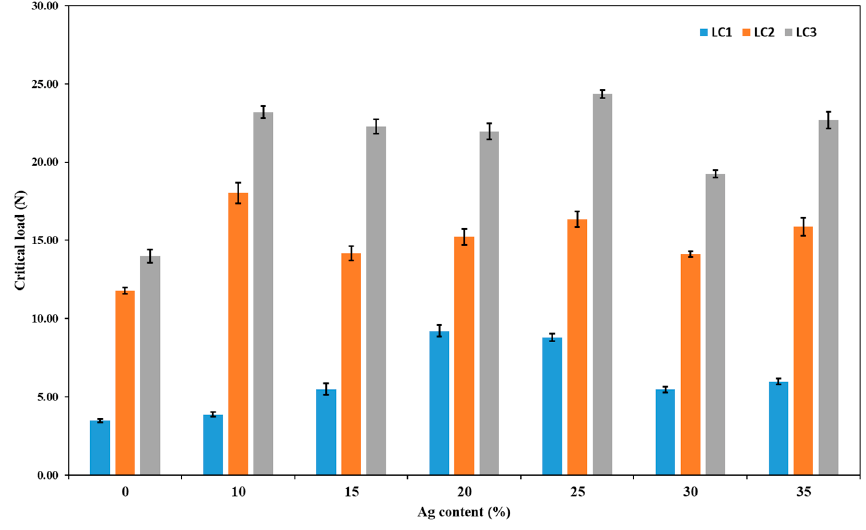
Figure 8. Critical load (LC1, LC2, and LC3) as a function of Ag content in the TiCu thin films.